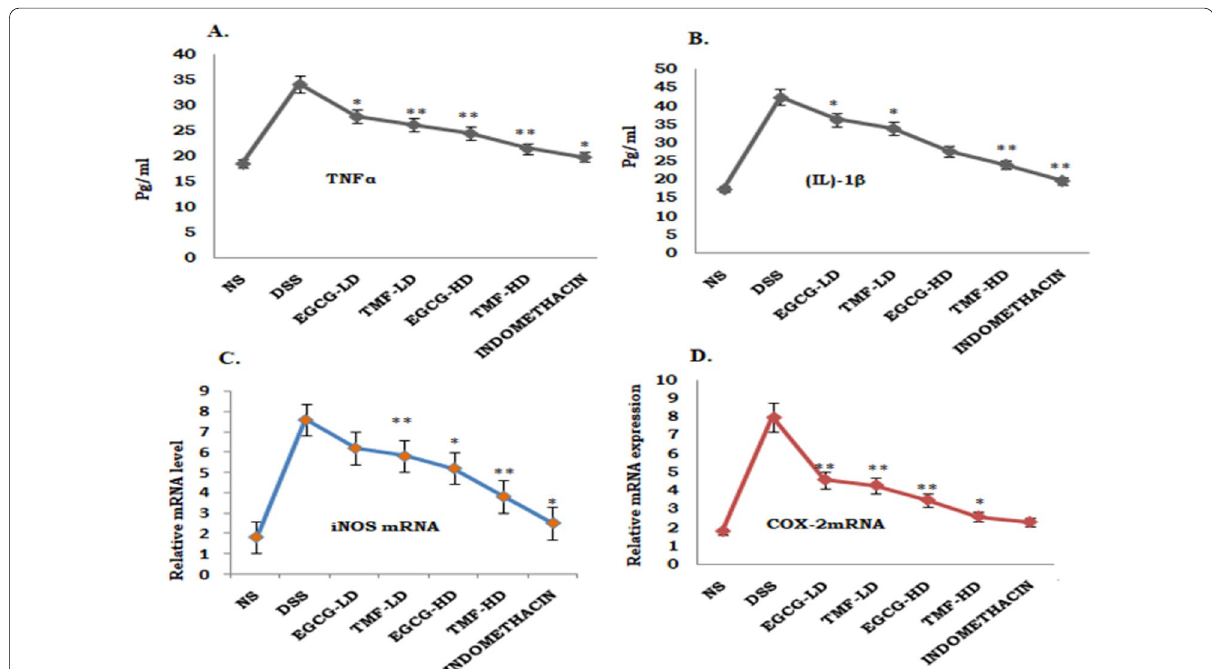
Fig. 6 Estimation of cytokines and inflammatory mediators: A Level of (IL)-1β; B TNFα expressions by ELISA; C iNOS mRNA; D COX-2 mRNA expressions by RT-PCR